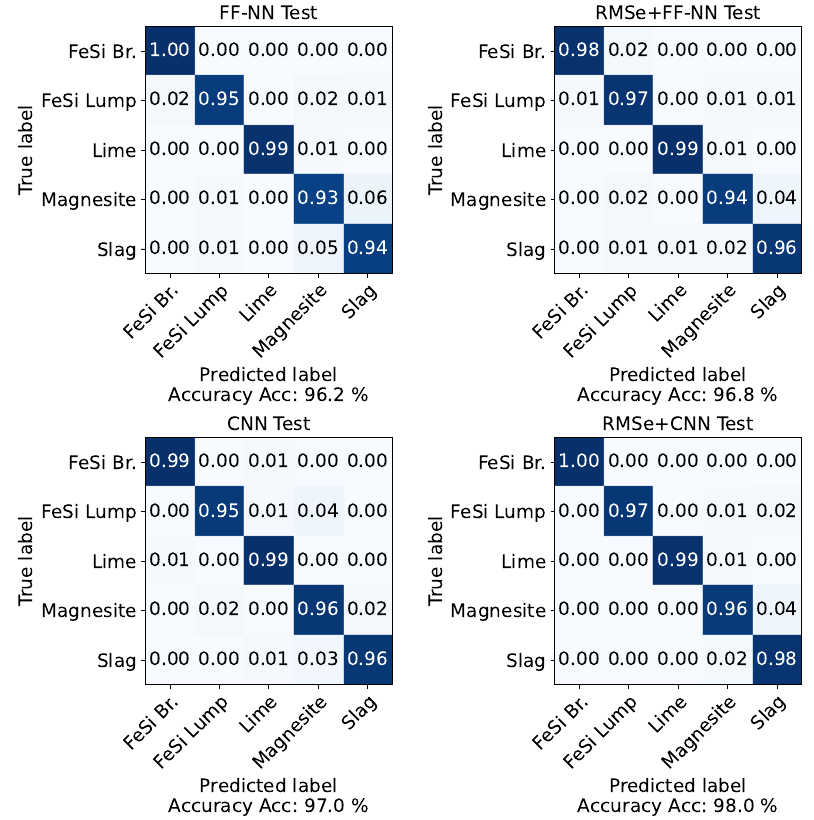
Figure 14. Achieved classification performance and confusion matrixes (from left to right) on test dataset splits: first row: FF-NN without preprocessing, FF-NN trained on RMSe preprocessed dataset second row: CNN without preprocessing, CNN trained on RMSe preprocessed